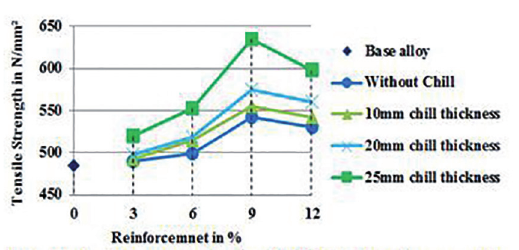
Figure 8: Tensile strength of Nickel based composite with varying chill thickness and % Garnet